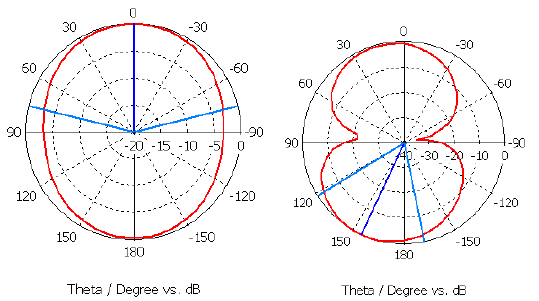
Figure 13. E and H plane radiation pattern at 5.98